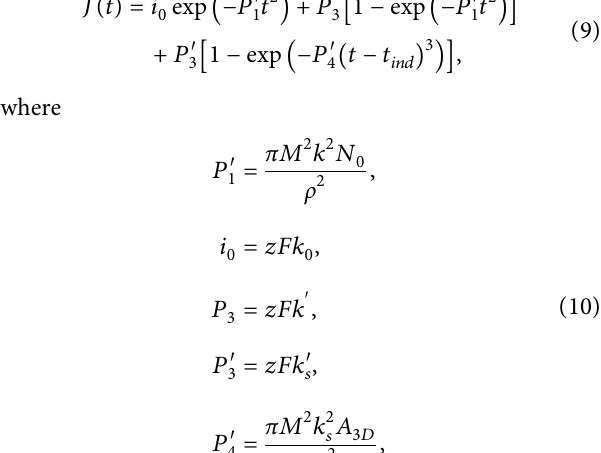
k ′ ), and 3D on temperature 0 ), log(